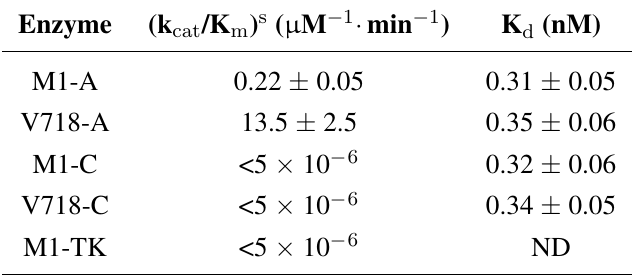
/K ) s and K ] of different ribozymes-mediated cleavage cat m d